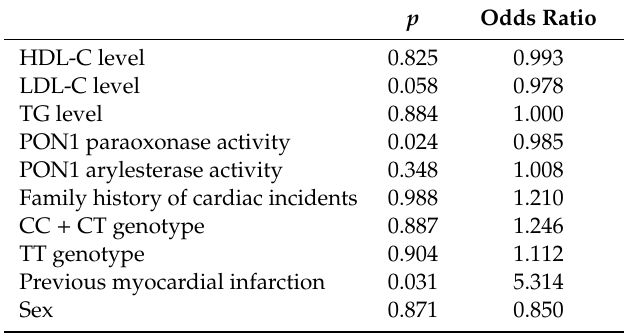
Table 5. Results of logistic analysis for association of diabetes mellitus with independent covariates.